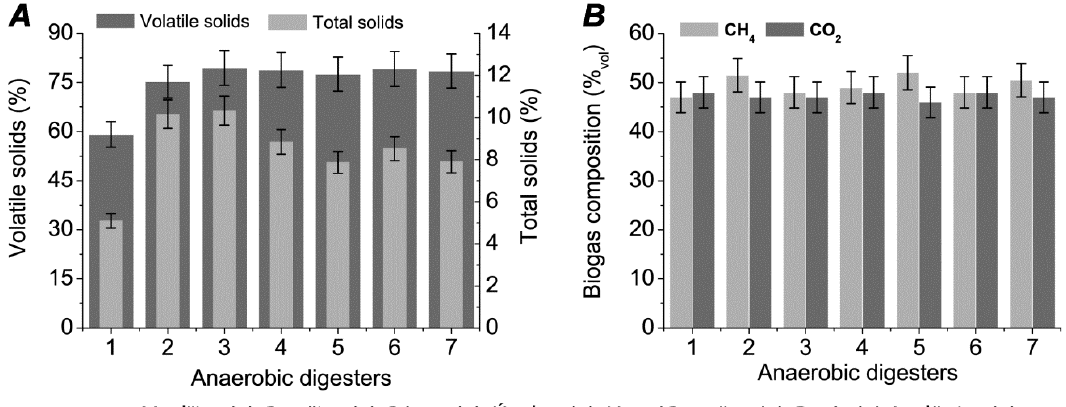
Figure 2. Amount of solids ( A ) and biogas production ( B ) (M ± SE, n = 3).